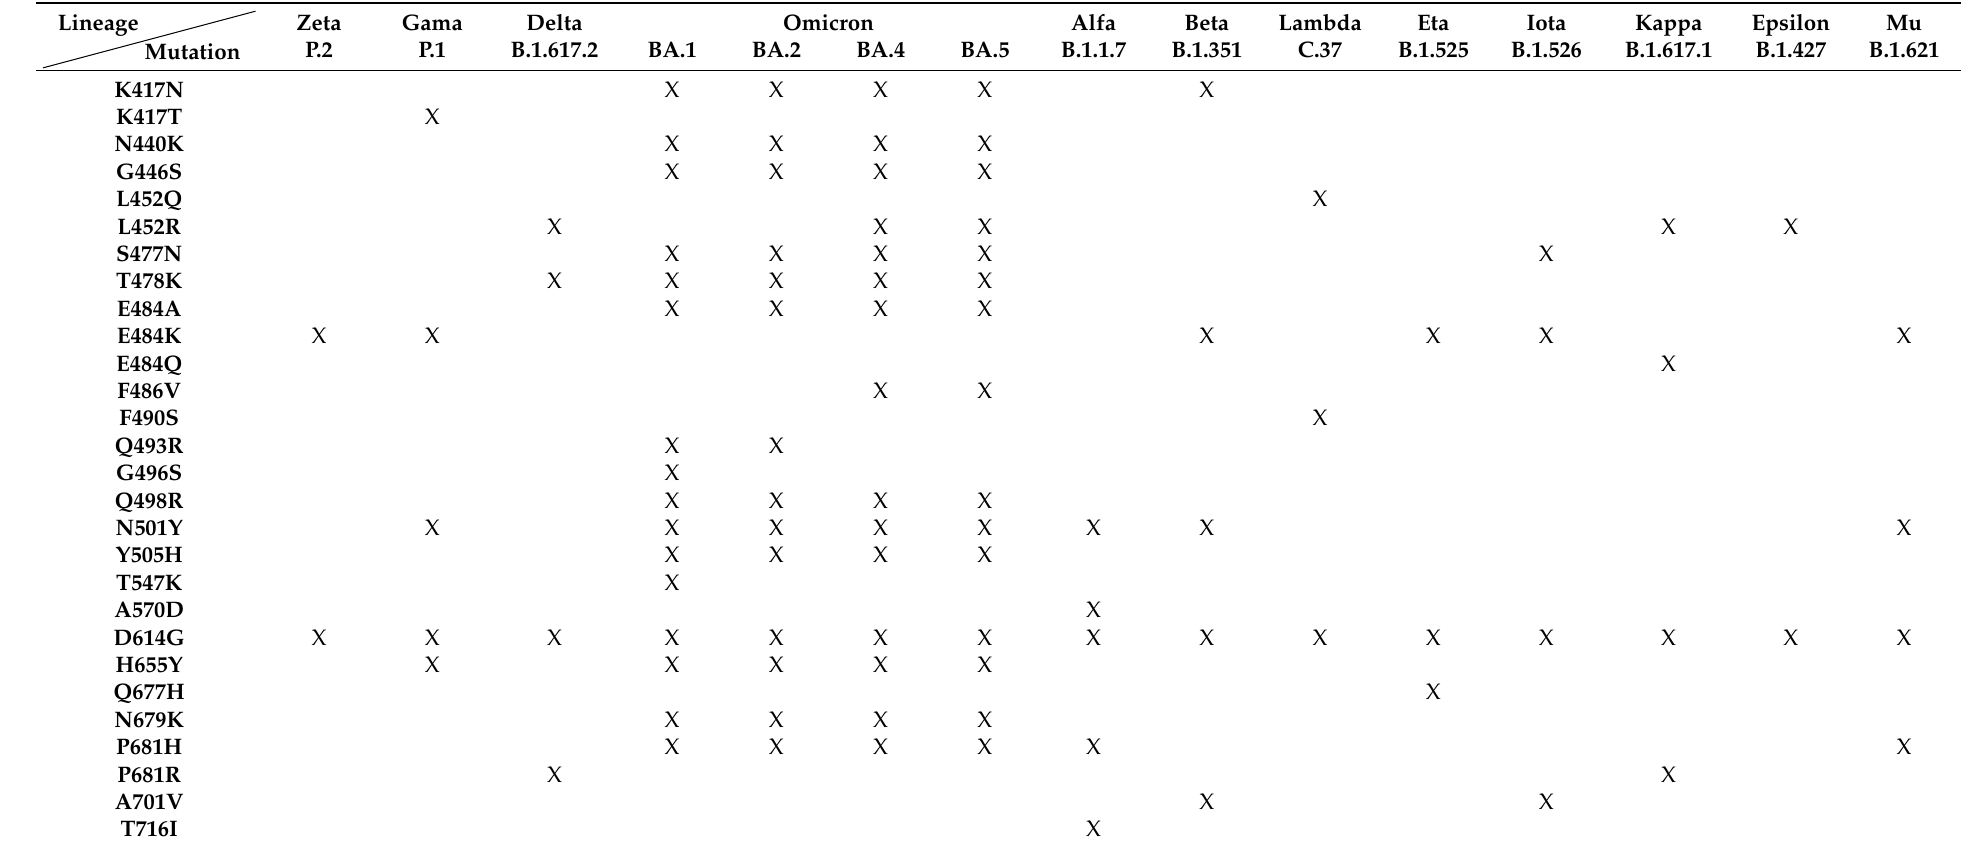
Table 2. Mutations and possible variants identified by the